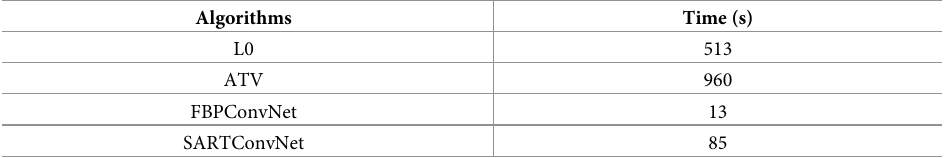
Table 6. Execution time with different